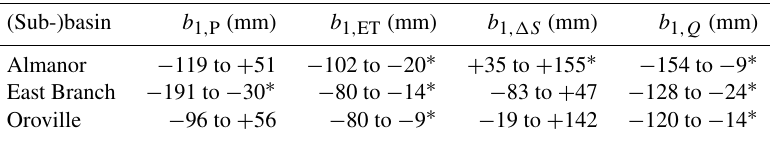
Table 4. Regression between observed and simulated water-balance components: confidence bounds of the regression parameter ruling shifts in performance during droughts (see Eq. 1). ET is the sum of ET and the groundwater sink (see Sect. 2.3.3). The asterisk ( ∗ ) denotes statistically significant elasticity values (that is, the sign of the confidence bounds agrees, 95% confidence level). (Sub-)basin b 1 , P (mm) b 1 , ET (mm) b 1 ,(cid:49)S (mm) b 1 ,Q (mm) Almanor − 119 to + 51 − 102 to − 20 ∗ + 35 to + 155 ∗ − 154 to − 9 ∗ East Branch − 191 to − 30 ∗ − 80 to − 14 ∗ − 83 to + 47 − 128 to − 24 ∗ Oroville − 96 to + 56 − 80 to − 9 ∗ − 19 to +